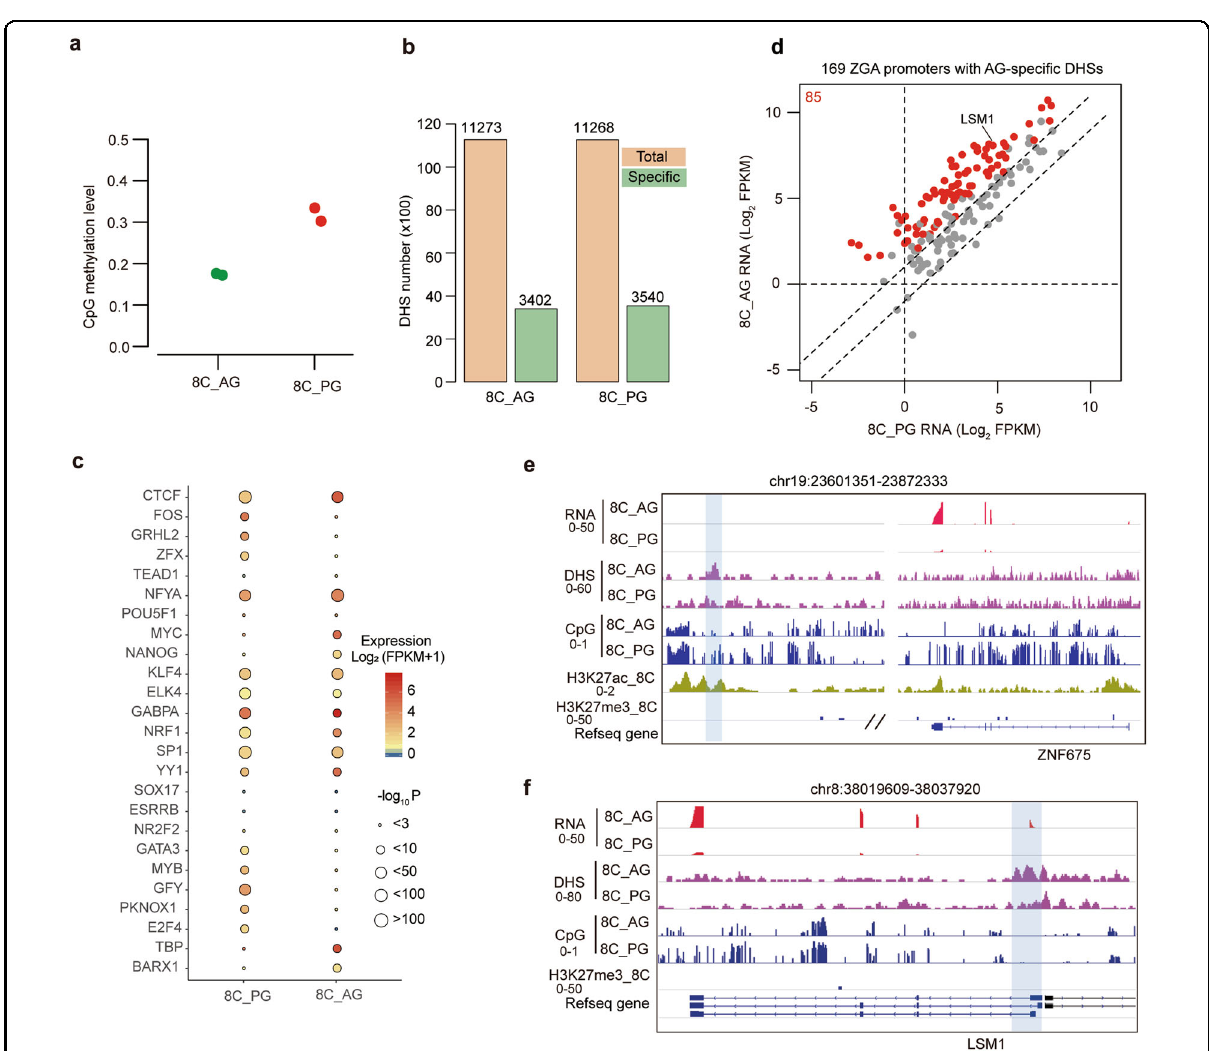
Fig. 4 Epigenetic states at ZNF675 and LSM1 loci. a Plot showing the global DNA methylation levels of parental genomes in human PG and AG embryos at the 8-cell stage. b Bar plots showing the number of total DHSs and parentally speci fi c DHSs in human PG and AG embryos at the 8-cell stage. c Transcription factor binding motif enrichment in the parentally speci fi c DHSs at the 8-cell stage. The sizes of circles represent the p values of enrichment. The colors in the circles represent the expression levels of transcription factors in the corresponding PG or AG embryos. d Scatter plot showing the RNA expression of the ZGA genes whose promoters harbor AG-speci fi c DHSs. e Genome browser view of RNA expression and epigenetic states at ZNF675 locus. The blue shadow indicates a putative enhancer region associated with ZNF675. f Genome browser view of RNA expression and epigenetic states at LSM1 locus. The blue shadow indicates the promoter region of